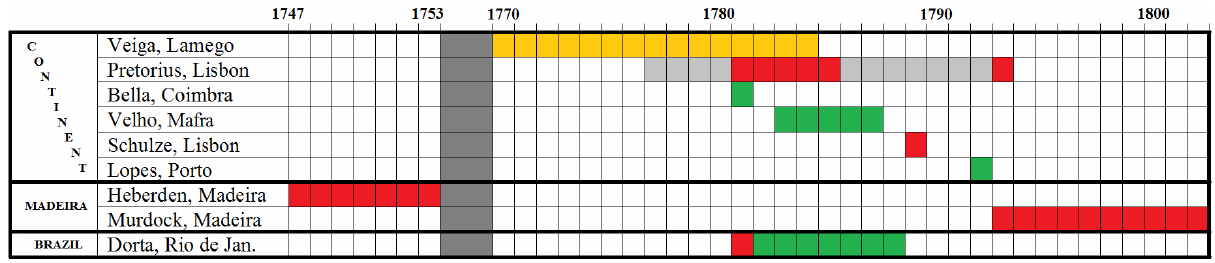
Fig. 2. Meteorological data availability in Portugal and overseas during the 18th century (yellow: annual data; red: monthly data; green: daily Figure 2. Meteorological data availability in Portugal and overseas during the 18 th data; grey: lost data). century (yellow: annual data; red: monthly data; green: daily data; grey: lost data).